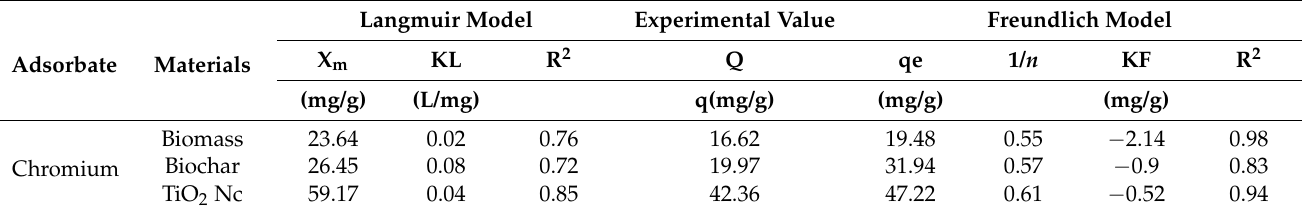
Table 4. Comparison of Langmiur and Freundlich